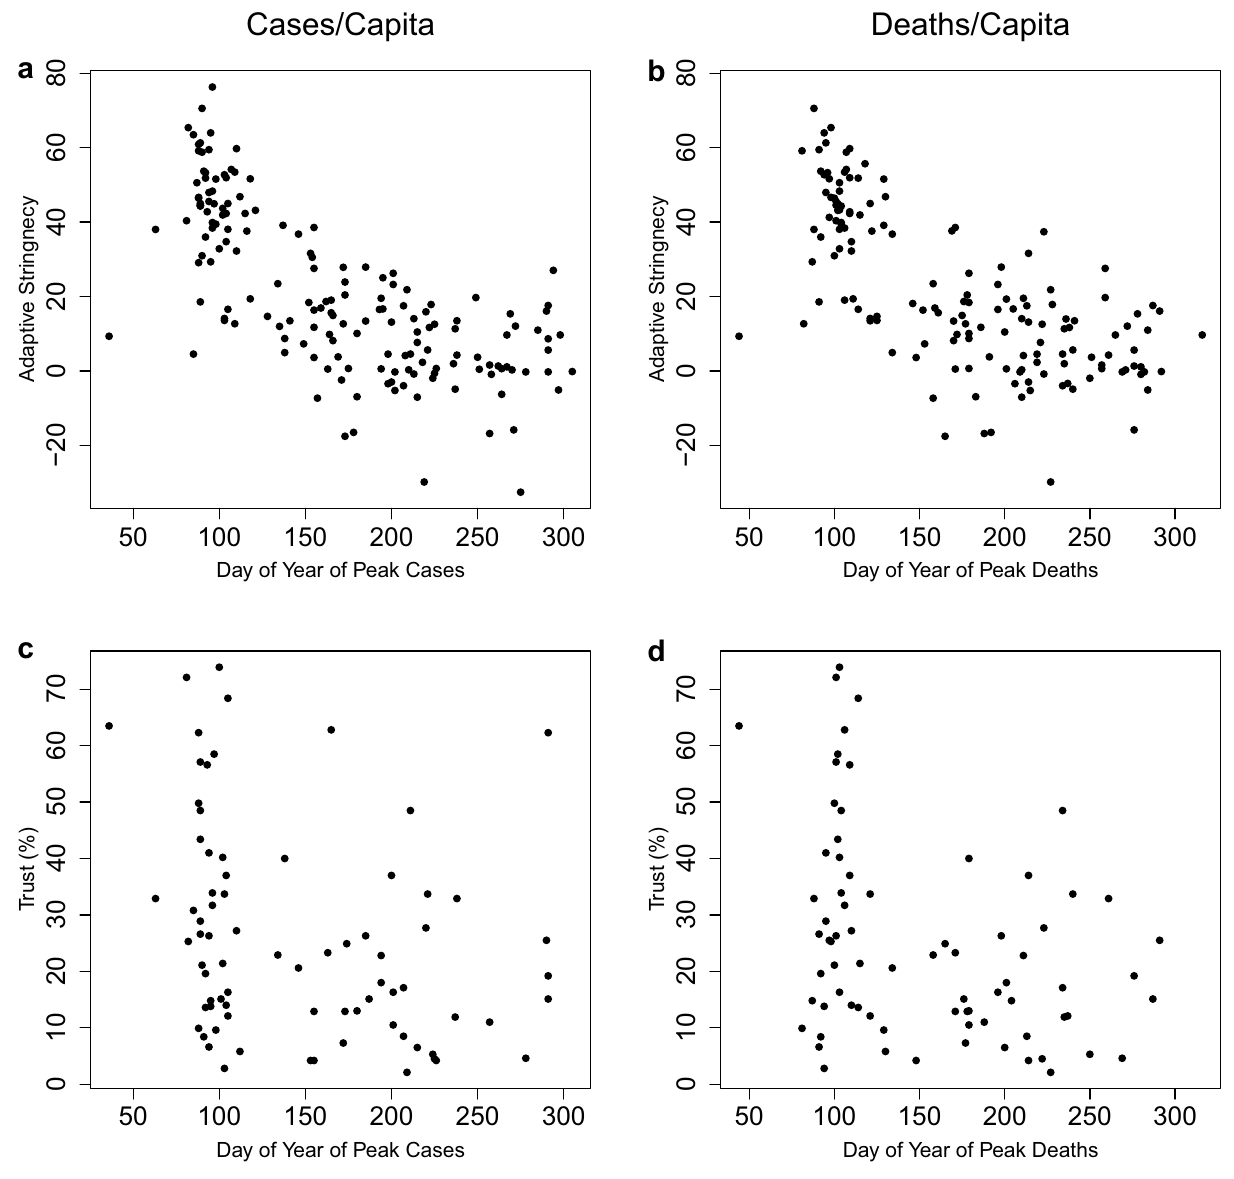
Figure 7. Relationships between peak timing, adaptive stringency, and trust: ( a ) day of year of peak cases/capita versus adaptive stringency (n = 166, ρ =−0.74, p < 0.0001). ( b ) day of year of peak deaths/capita versus adaptive stringency (n = 154, ρ =−0.72, p < 0.0001). ( c ) day of year of peak cases/capita versus trust (n = 77, ρ =−0.37, p < 0.001). ( d ) day of year of peak deaths/capita versus trust (n = 75, ρ =−0.30, p <